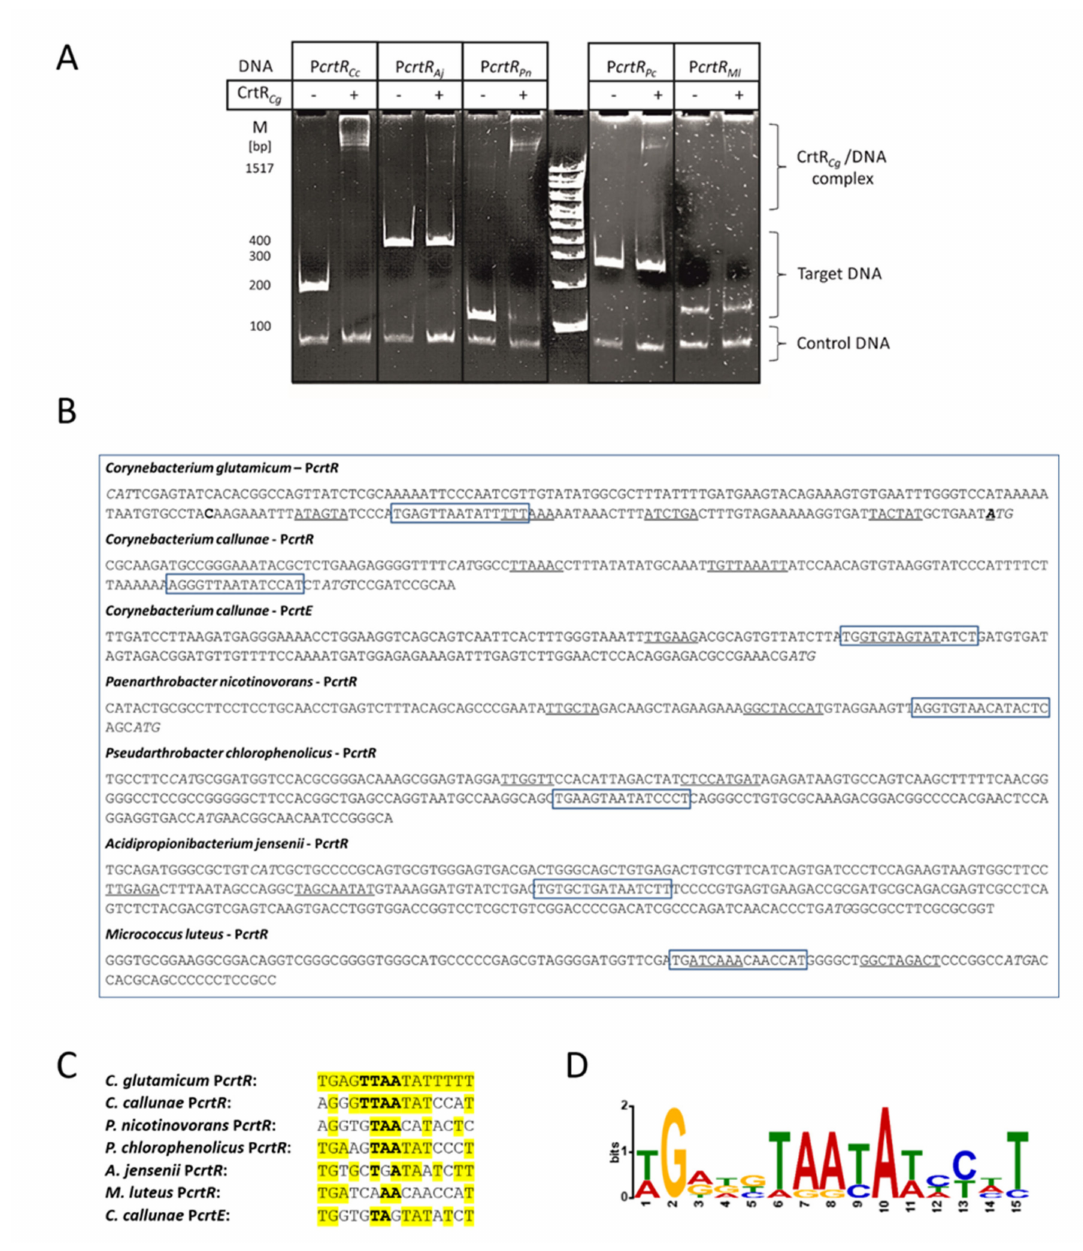
Figure 3. Characterization of CrtR from C. glutamicum in vitro. ( A ) Bandshift assays of His-tagged CrtR protein from C. glutamicum (CrtR Cg ) and the intergenic DNA sequences between the crtR orthologs from C. callunae , A. jensenii , P. nicotinovorans , M. luteus and P. chlorophenolicus, and the respective divergently transcribed genes. ( B ) Putative -10 and -35 promoter DNA sequences (underlined), translation start codons (italics) and the putative conserved CrtR binding sequences (boxed). The mapped transcriptional start sites of C. glutamicum crtR and crtE are given in bold. ( C ) Putative conserved CrtR binding sequences (conserved nucleotides are given in yellow; the TTAA sequence that was shown previously to be required for C. glutamicum CrtR binding by mutational analysis is depicted in bold face). ( D ) The graphical representation of the derived consensus DNA binding motif of the CrtR proteins from C. glutamicum , C. callunae , A. jensenii , P. nicotinovorans , M. luteus and P. chlorophenolicus (designed using